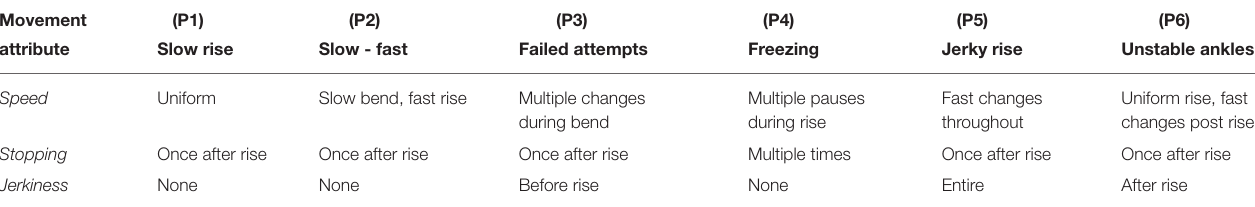
Multiple pauses Fast changes Uniform rise, fast during bend during rise throughout changes post rise